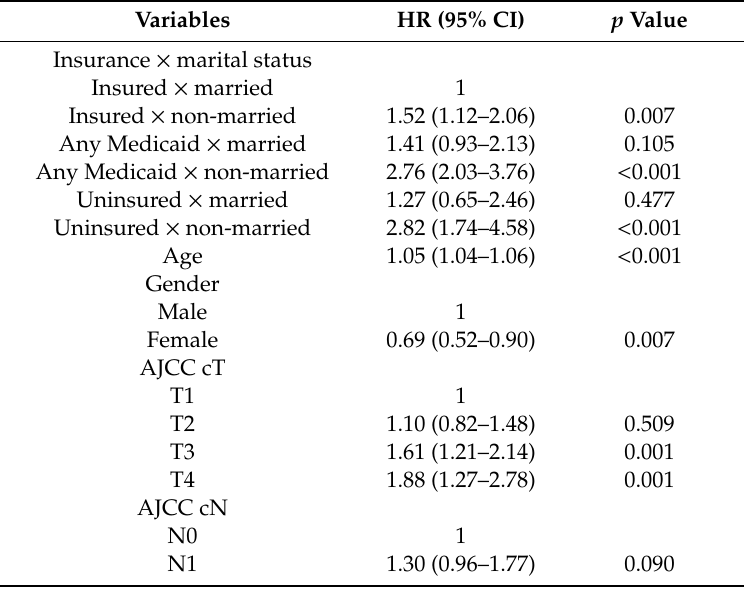
Table 4. Multivariate analysis for 5-year